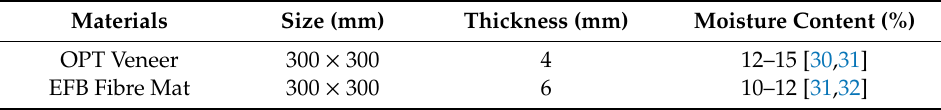
Table 2. Specification of oil palm trunk (OPT) veneer and empty fruit bunch (EFB) fibre